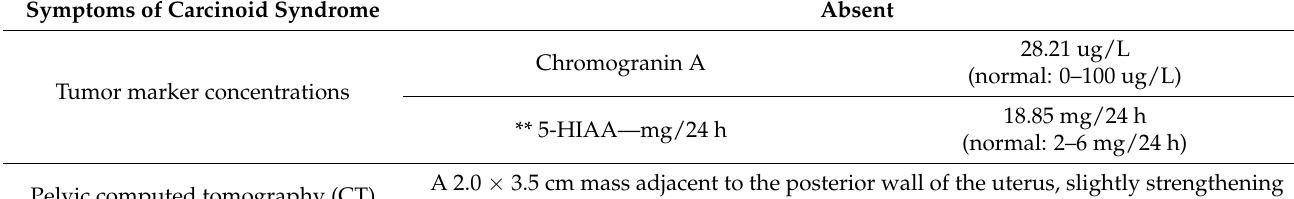
Table 1. Clinical symptoms and results of consecutive biochemical and imaging diagnostic steps performed after operation in a 16-year-old girl with an ovarian neuroendocrine tumor after operation. Symptoms of Carcinoid Syndrome Absent Chromogranin Tumor marker concentrations